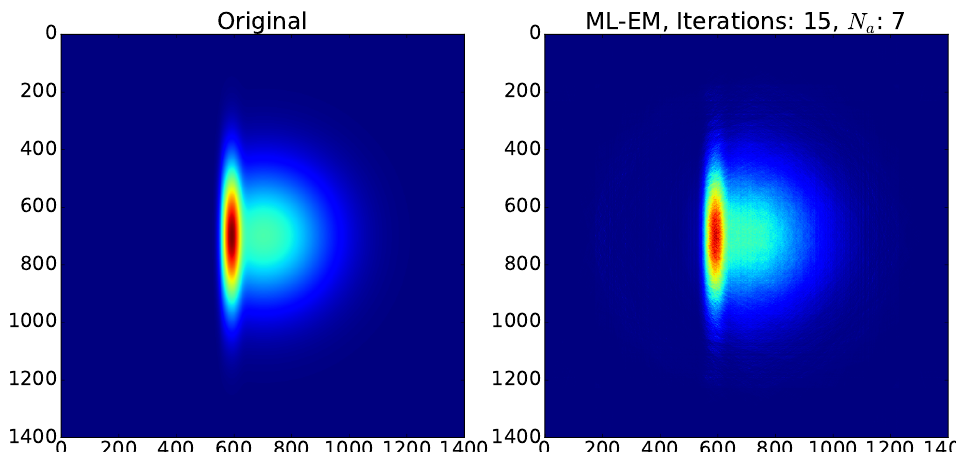
Figure 9. Reconstruction by ML-EM from seven projections with artificial Gaussian noise, σ = 0.01.